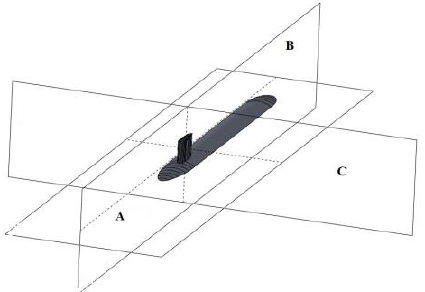
Figure 4. The diagram of the planes. Plane A is longitudinal, Plane B is longitudinal, and Plane C is transversal.